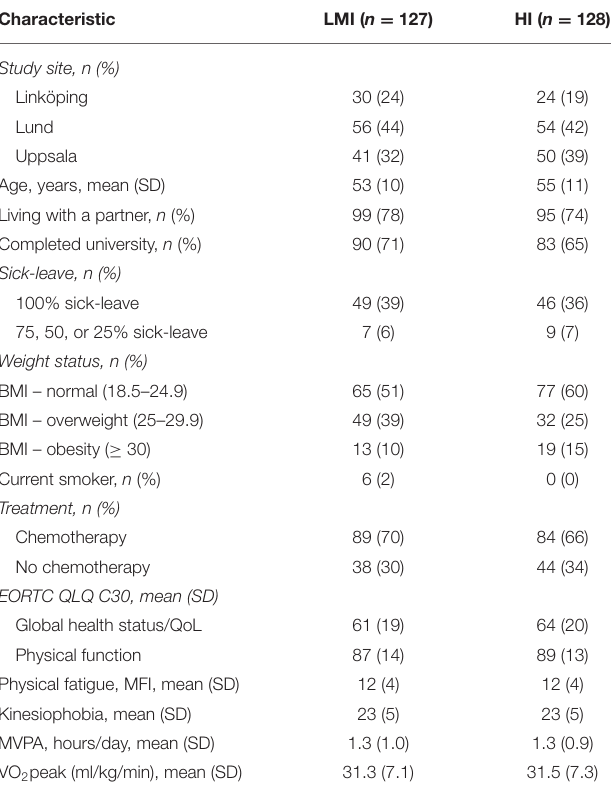
TABLE 2 | Results of the analyses examining potential moderators of HI vs. LMI exercise on VO 2 peak.